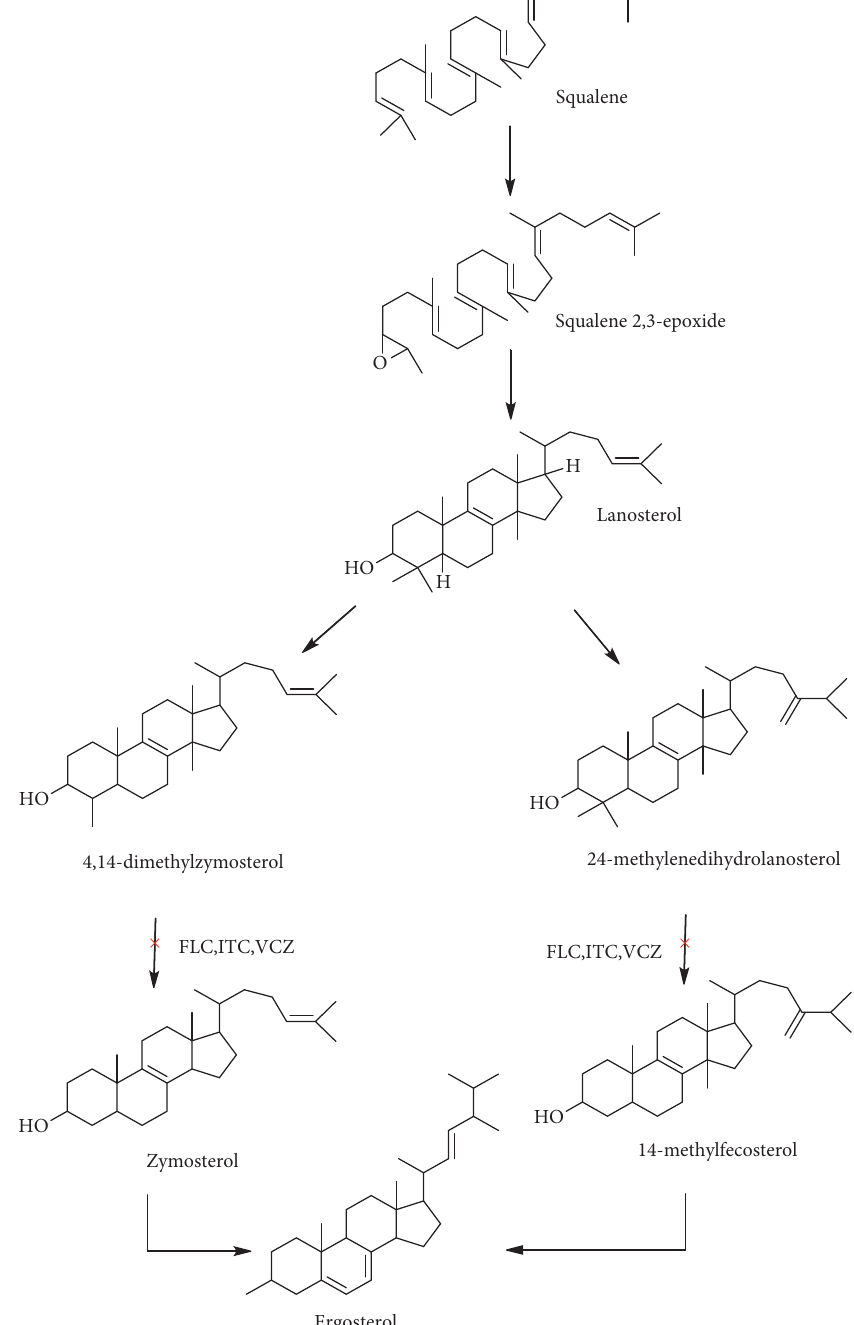
Scheme 16: Ergosterol biosynthesis inhibitor